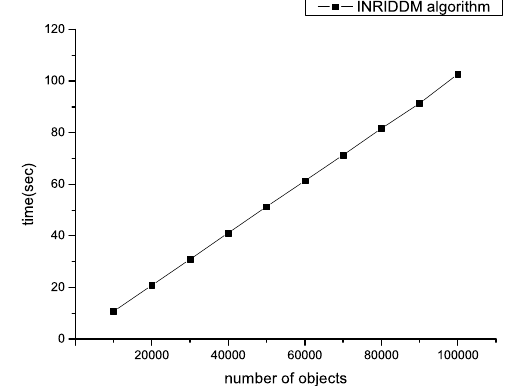
Fig. 1. The running time(in seconds) of INRIDDM on large data